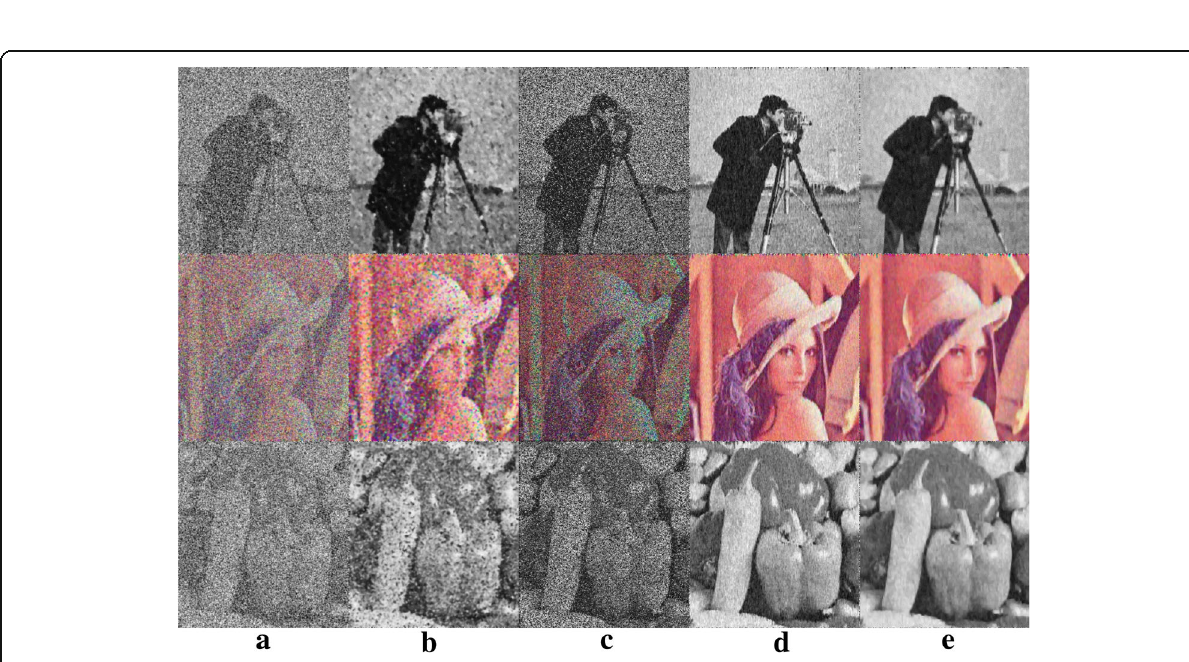
Fig. 5 Performance of a RF ( λ = 0.25), b AMD ( λ = 0.25), c AADF ( λ = 0.25), d FORADF ( λ = 0.25), and e FORADF ( λ = 1) for high-density mixed noise. λ represents the control parameter, and n represents the number of iterations. The results are given for high-density mixed noise, i.e., Gaussian noise of variance 0.1 plus salt and pepper noise of density 70%